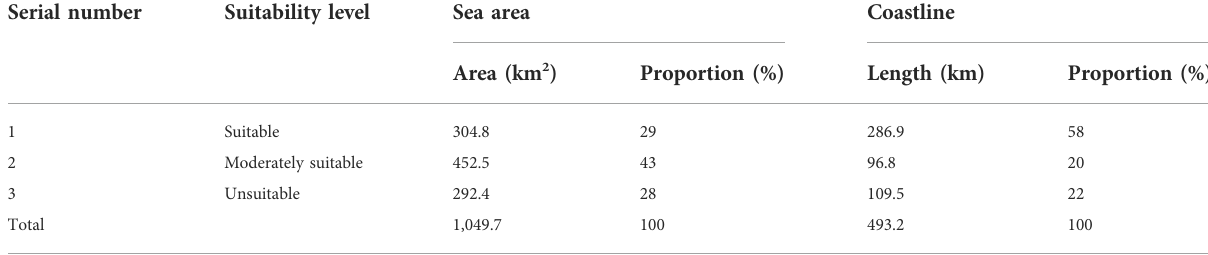
TABLE 10 Statistics for the Rongcheng offshore area evaluation